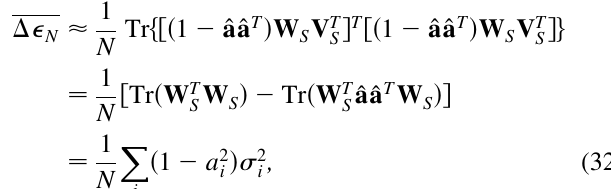
FIG. 9. Relative singular values ( (cid:3) corresponding to 100 CLIC machines obtained after beam-based alignment of randomly misaligned machines. The importance of the majority of directions is